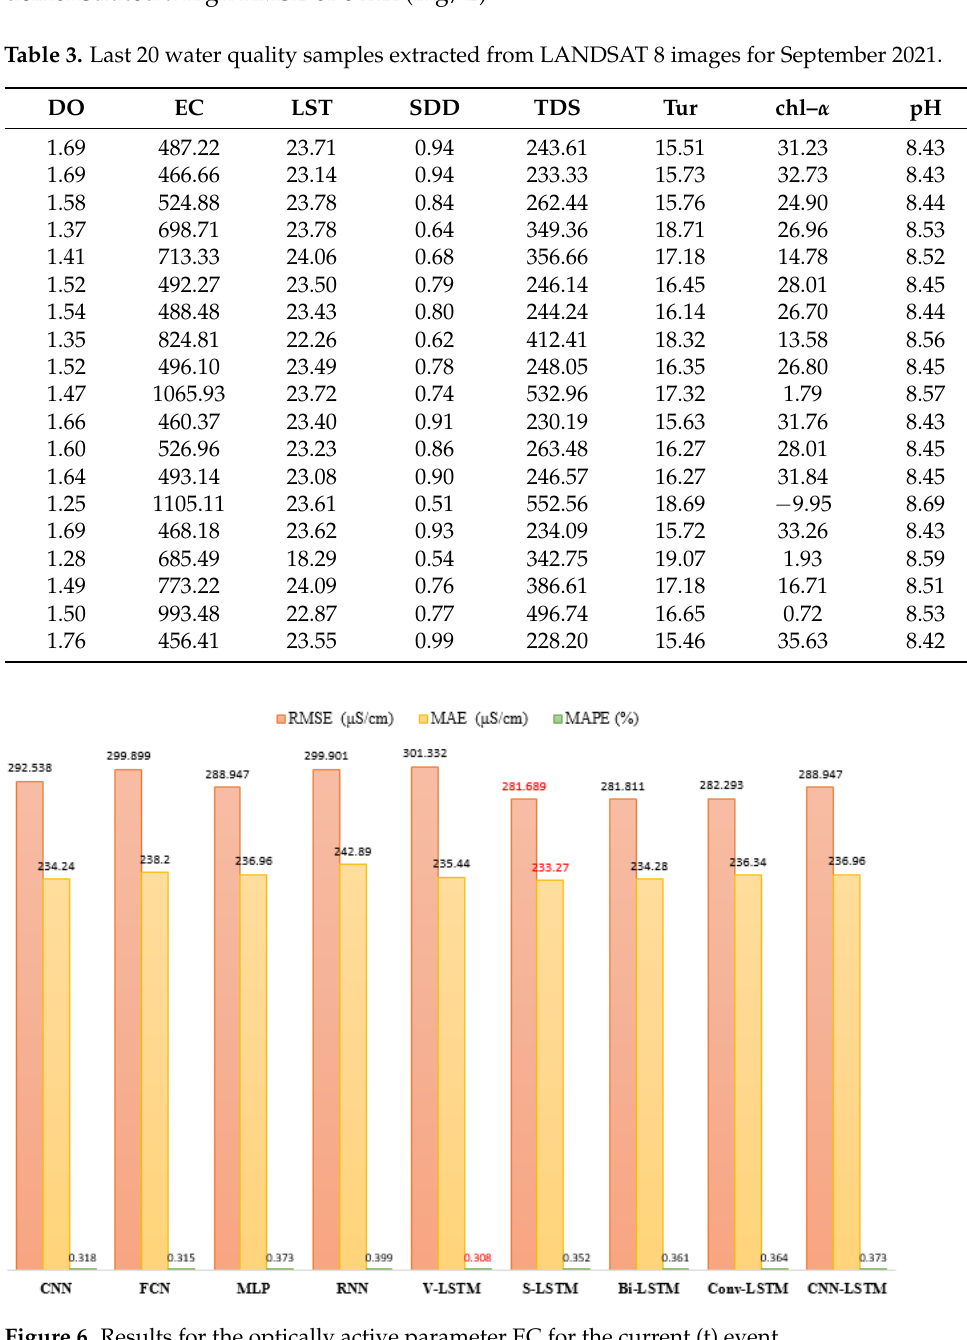
Figure 6. Results for the optically active parameter EC for the current (t) event. Predictions of future event parameters: For multi–step forecasts, a lag time period of one (t − 1) was used to predict the next three events, i.e., t + 1, t + 2, and t + 3. For the future time event predictions of optically active and inactive parameters, EC and DO, Bi–LSTM performed the best among the other LSTM variants. For DO, V–LSTM and Bi–LSTM showed the minimum RMSE values of 0.2 and 0.199 (mg/L), respectively. Other